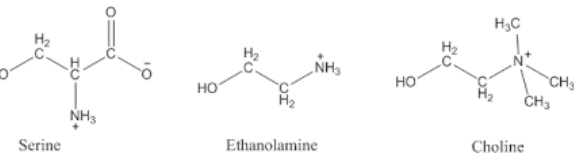
Figure 2. Chemical structures of ethanolamine and